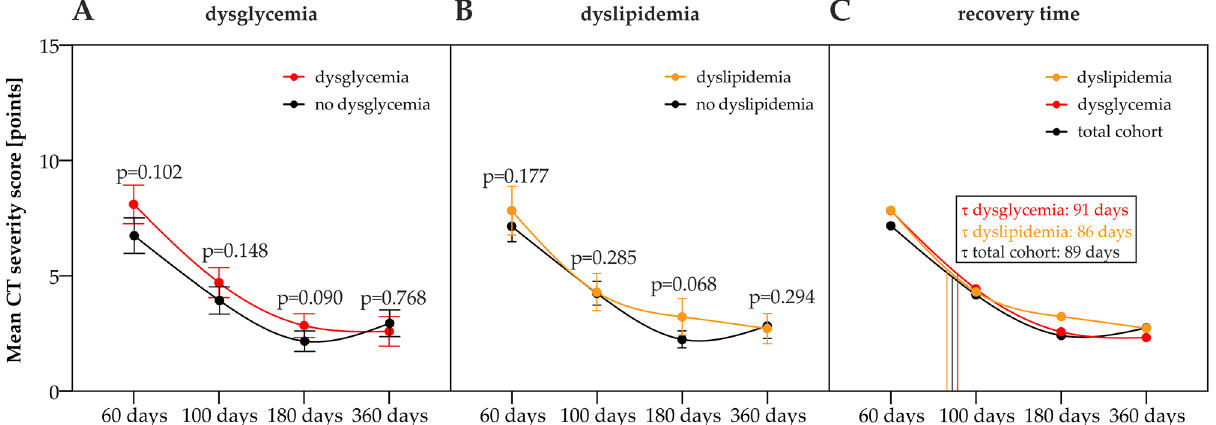
Figure 5. Pulmonary recovery after COVID-19 in patients with dysglycemia or dyslipidemia. Structural pulmonary impairment was assessed with computed tomography (CT) at four post-COVID-19 follow-ups. The severity of structural lung abnormalities was graded from 0 to 25 points (the higher the more severe) as described in the methods section. Time-dependent structural lung recovery according to the presence/absence of dysglycemia ( A ) or dyslipidemia ( B ) are presented. ( C ) Structural lung recovery time resulting in a 50 percent (τ) reduction of CT lung impairment as compared to the early post-acute follow-up in individuals with dysglycemia, dyslipidemia, and the total cohort are shown, whereas we found no significant differences in lung recovery time between the investigated subgroups. Mann–Whitney-U test ( A , B ) and Kruskal–Wallis test ( C ) were performed to analyze statistical differences between subgroups for each time point. Points indicate means, error bars depict standard error (SE). N 60days = 145, N 100days = 138, N 180days = 119, N 360days =